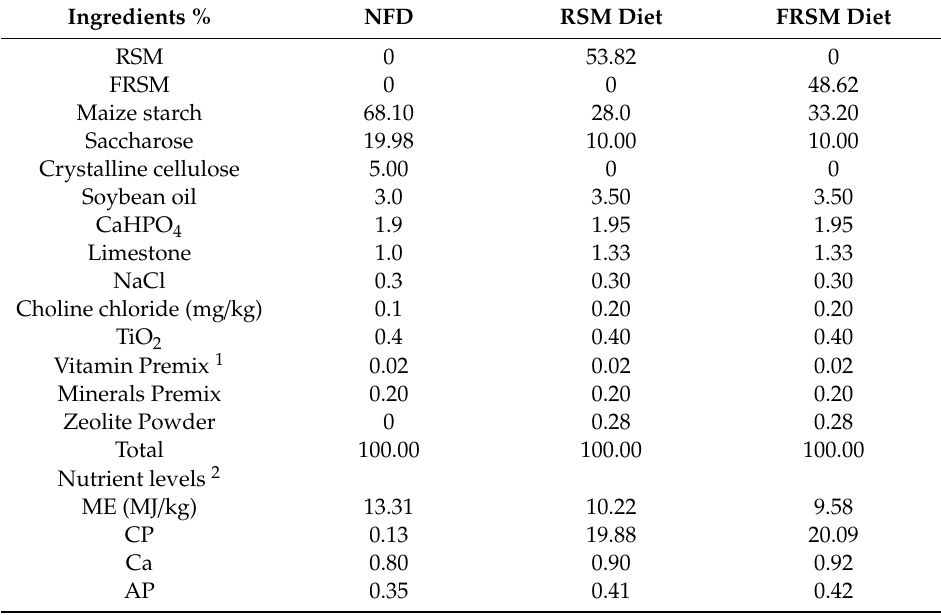
Table 4. Dietary composition and nutrient levels of the experimental diets for the apparent ileal digestibility (AID) and standardized ileal digestibility (SID)